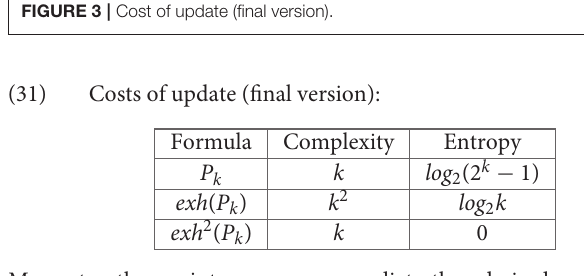
FIGURE 3 | Cost of update (final